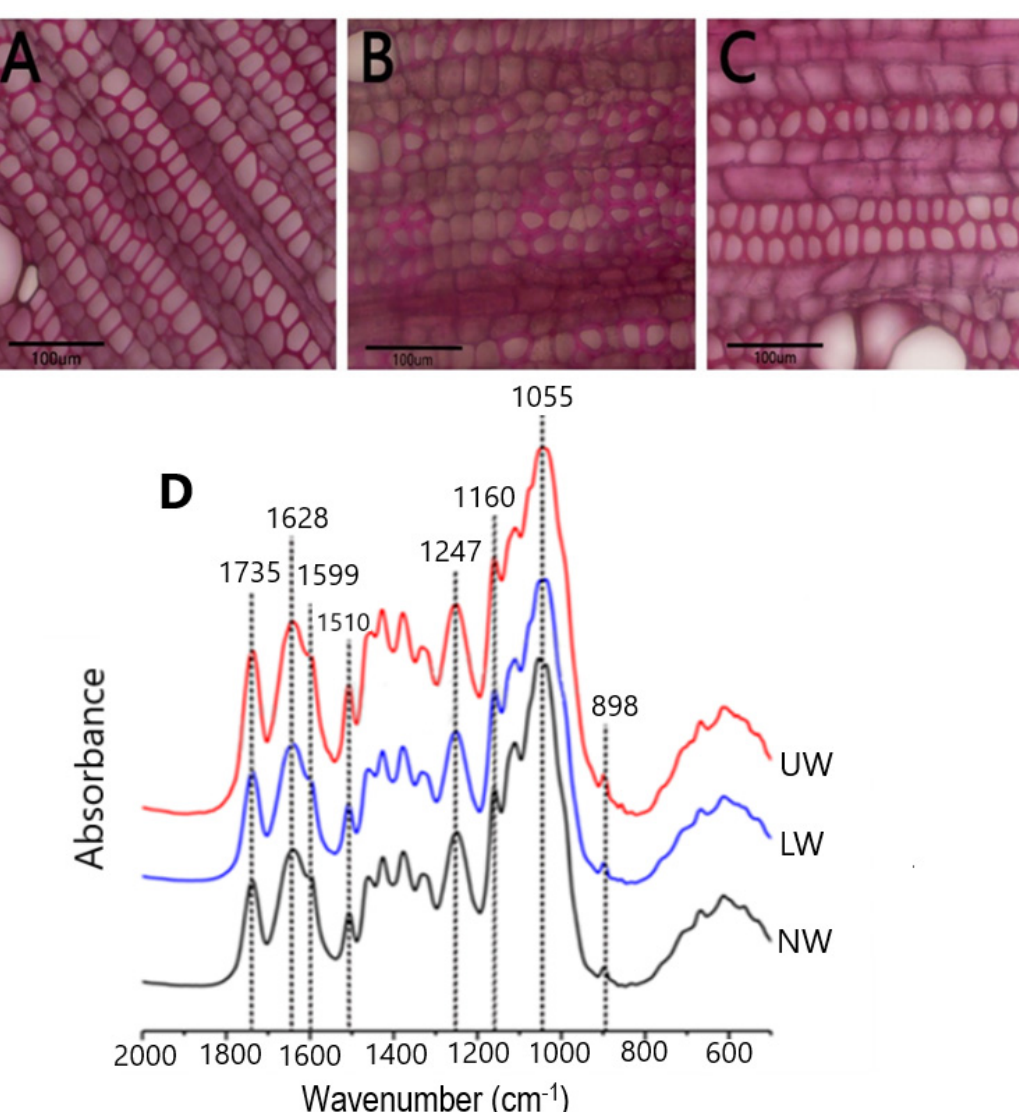
Figure 1. Microscopic observation of stem sections. ( A ) Normal wood (NW), ( B ) lower wood (LW) and ( C ) upper wood (UW) formed in response to bending stress. Staining was performed using phloroglucinol. No clear G layer formation was seen in TW. ( D ) Results from FT-IR spectroscopy of N. cadamba wood: infrared spectra of NW, LW and UW samples.